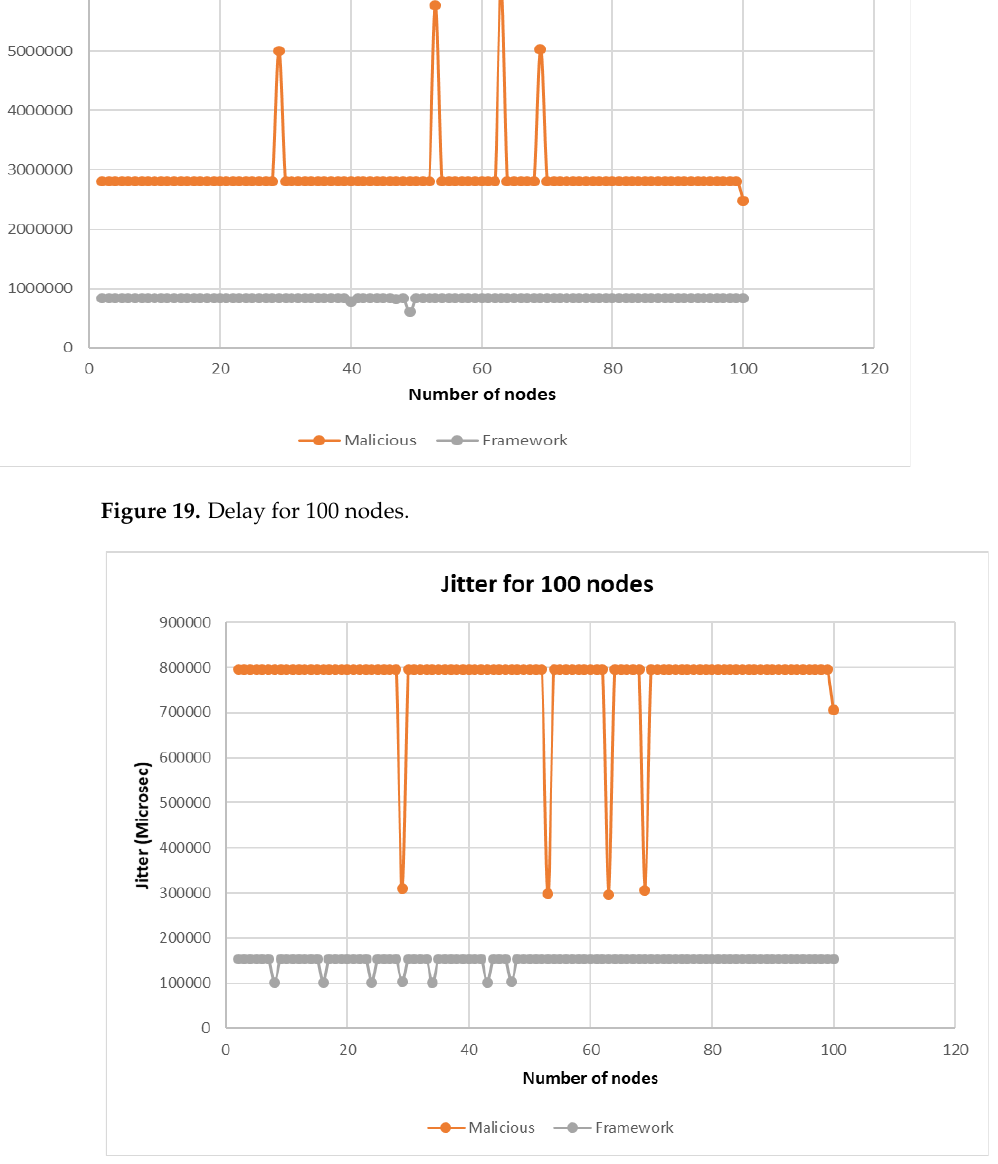
Figure 20. Delay for 100 nodes. Figure 20. Jitter for 100